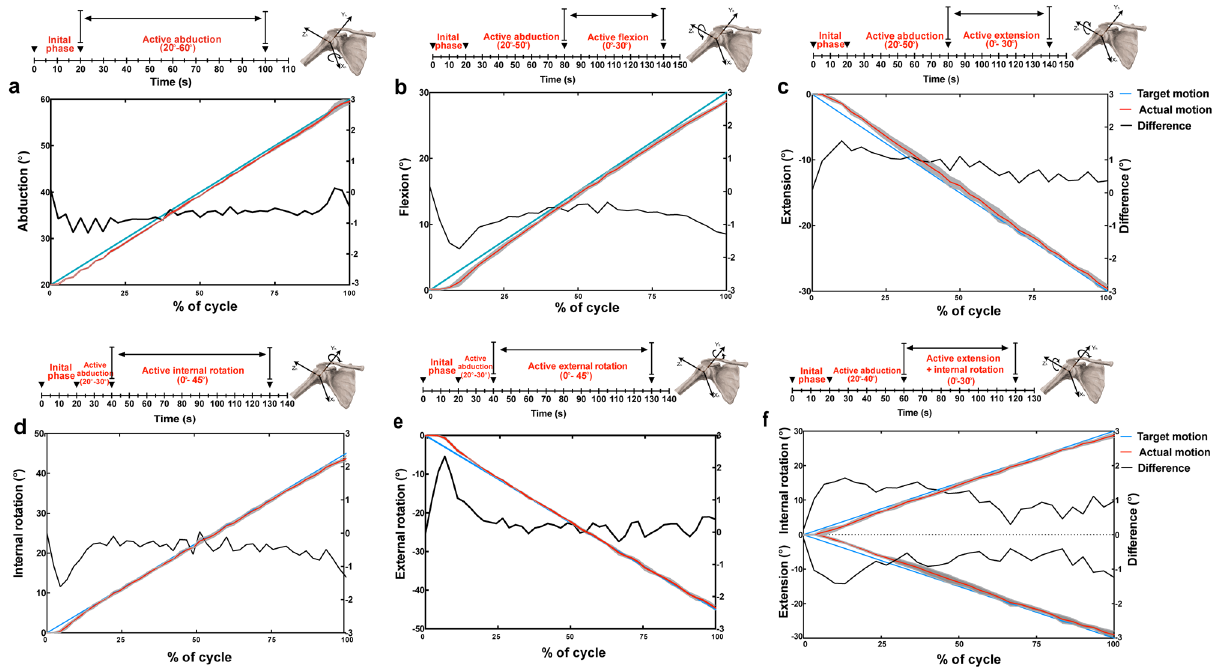
Figure 2. The performance of the simulator during active motions. ( a – f ) . The blue lines represent the target motions for active simulation and the red lines indicate the average of actual motions of all specimens during active abduction ( a ), flexion ( b ), extension ( c ), internal rotation ( d ), external rotation ( e ) and extension&internal rotation ( f ) cycles; the grey areas represent the standard deviations of actual motions; the black lines represent the mean deviations between the target and actual motions.